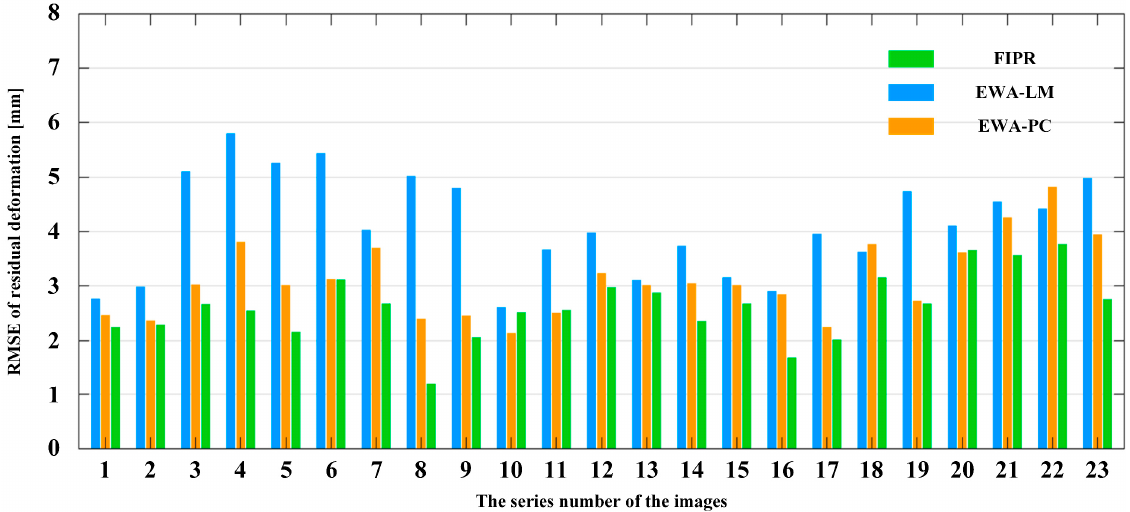
15 of 20 Figure 10. Correlation analysis between the time-series deformation results and the elevations of groundwater level (EWA-LM: linear model with equal weight accumulation; EWA-PC: Poisson curve with equal weight accumulation; UWL: elevation of groundwater level) ( a ): P4; ( b ): P5; ( c ): P6. To verify the modeling accuracy of FIPR, the magnitude of the high-pass (HP) defor- mation component was utilized here. According to [43], the HP deformation component can characterize the modeling accuracy of the deformation models. The smaller the HP deformation component, the higher the modeling accuracy. The HP deformation of each interferogram obtained through the FIPR was compared with those of EWA-PC and EWA-LM. Figure 11 shows a comparison of the HP deformation over all the high coher- ence points for each interferogram. As shown in Figure 11, for all the interferograms, the